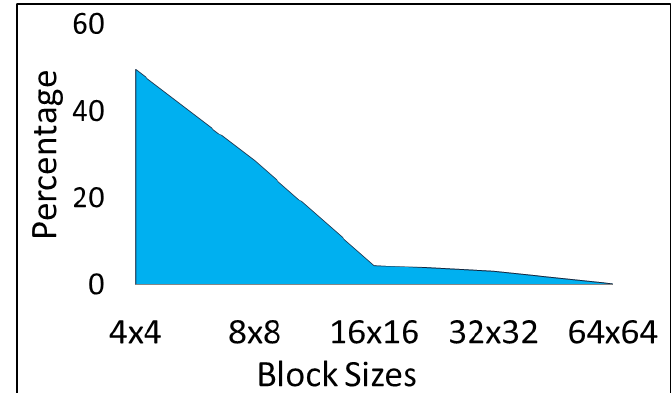
Figure 2. RD cost similarity among